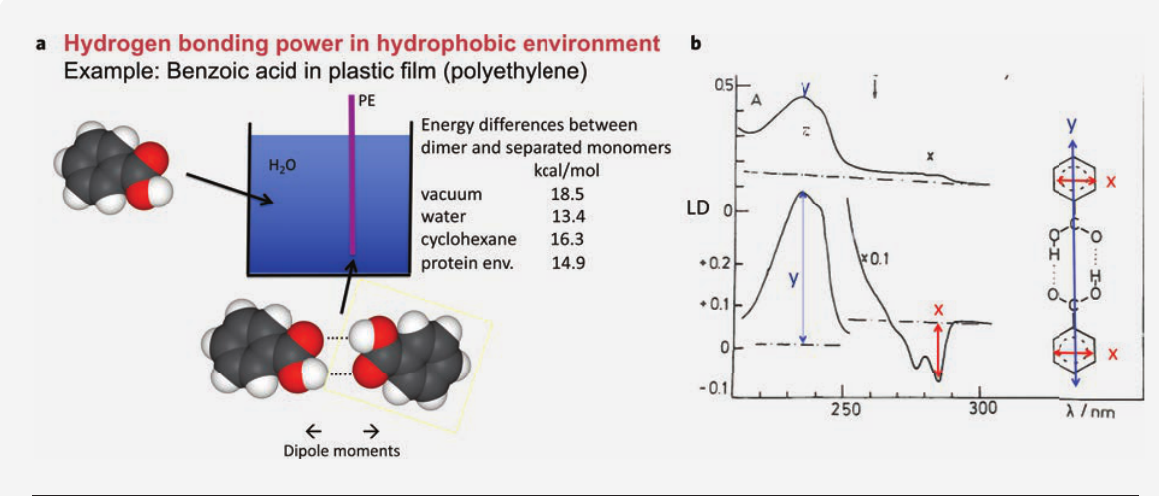
Figure 1. Hydrogen bonding makes polar benzoic acid change into a non-polar dimer (a). Theory shows that dimer is more stable than monomer in vacuum or non-polar solvent than in water. That the dimer is selectively absorbed and oriented in stretched polyethylene fi lm was discovered 42 years ago with polarized light (Linear Dichroism, LD) spectroscopy (b) 14